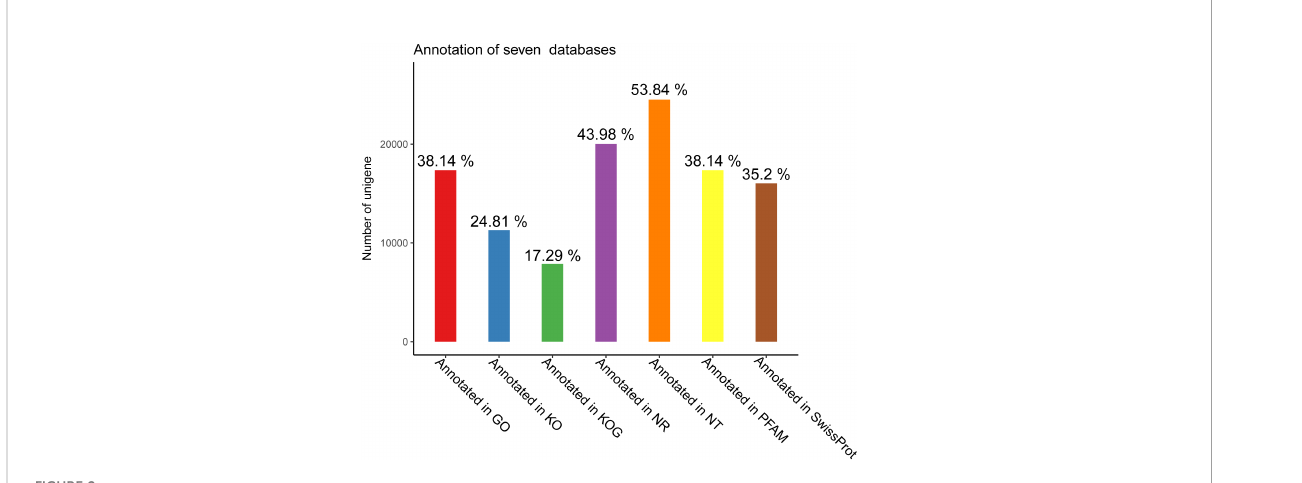
FIGURE 2 Annotated unigenes in seven